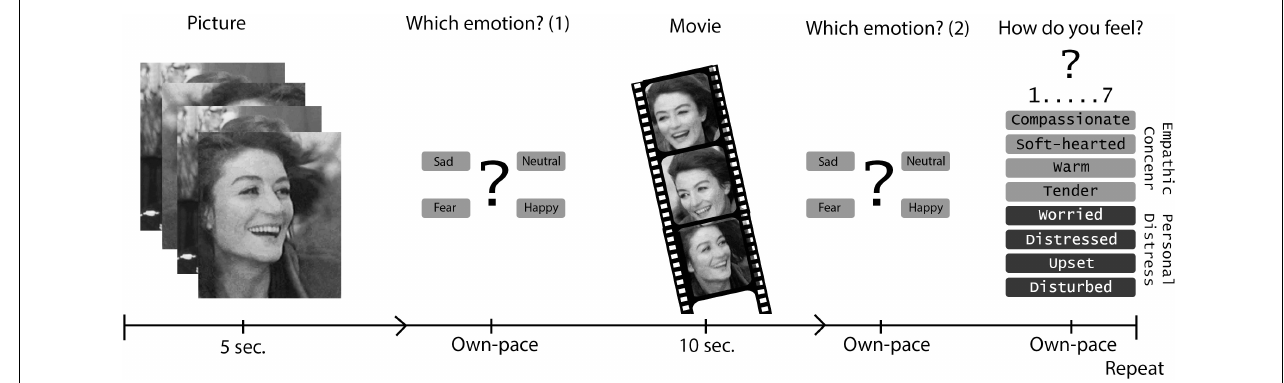
FIGURE 1 | Emotion task: Emotion recognition and affective